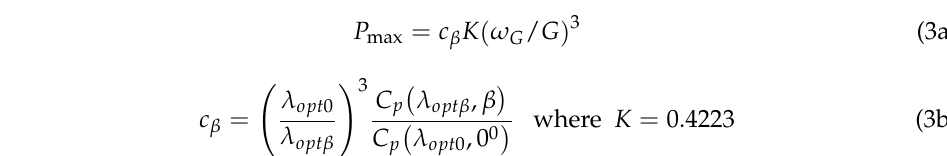
Figure 1. Power coefficient C p ( λ , β ) as a function of the turbine speed ratio for five values of the setting angle.